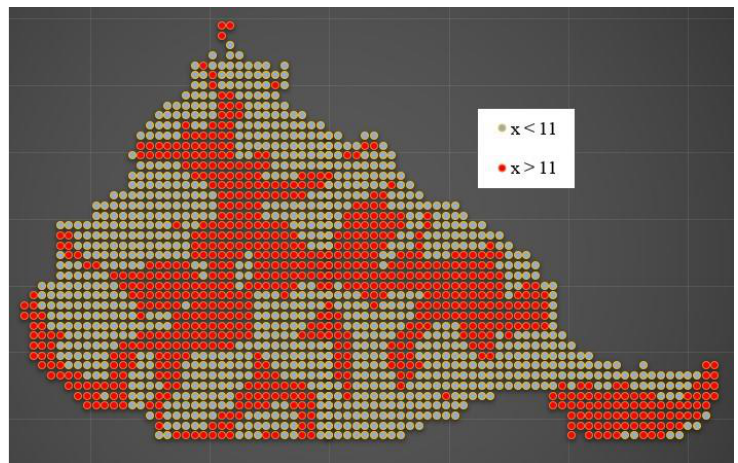
Figure 1. Daily solar radiation and clearness index for the island of Anafi.